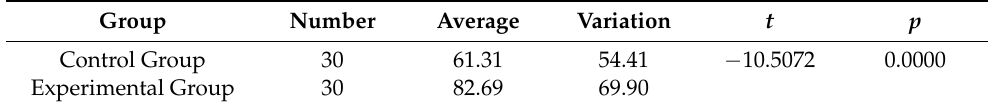
Table 3. After the experiment, t -tests for the experimental group and control group. Group Number Average Variation p Control